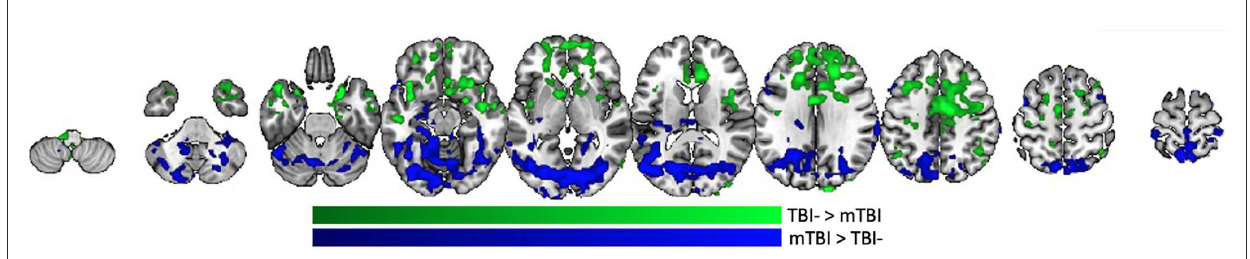
FIGURE3 Whole brain amygdala correlation differences between the TBI- and mTBI groups. Regions where the TBI-group (green) or mTBI group (blue) had significantly more resting state functional connectivity with bilateral amygdala.